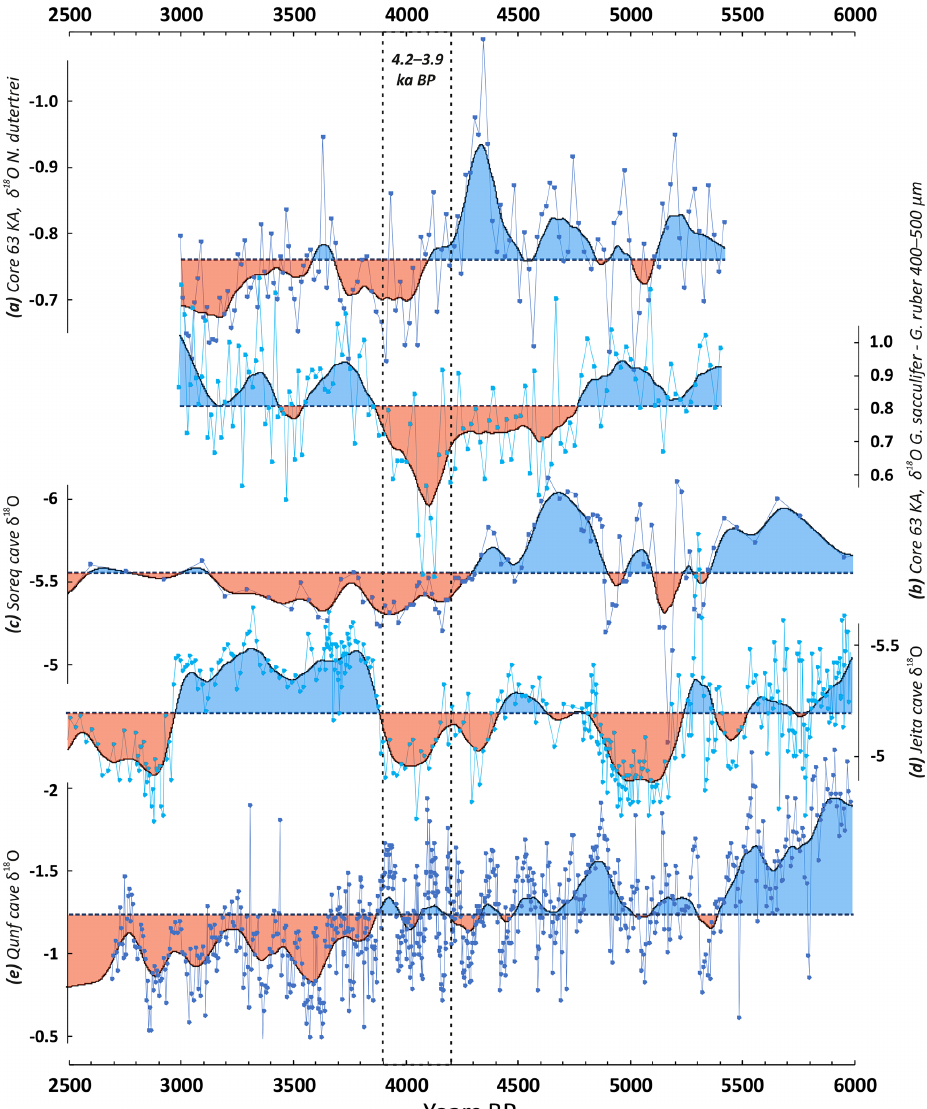
Figure 8. Comparison of the δ 18 O record of core 63KA with more distant records: (a, b) this study; (c) Bar-Matthews et al. (2003); (d) Cheng et al. (2015); (e) Fleitmann et al. (2003). The mean value for each record indicated by the horizontal dashed lines is taken for all available data between 6.0 and